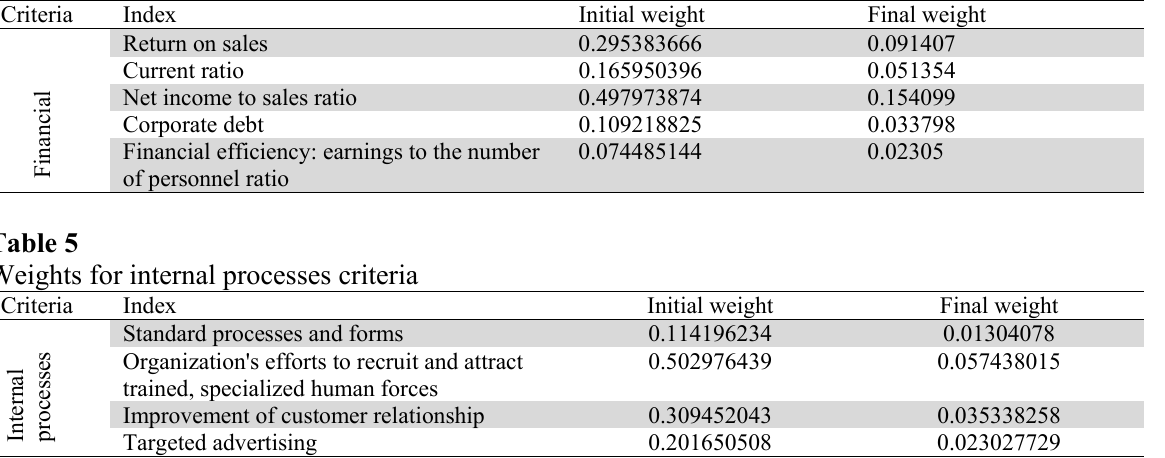
Weights for financial criteria